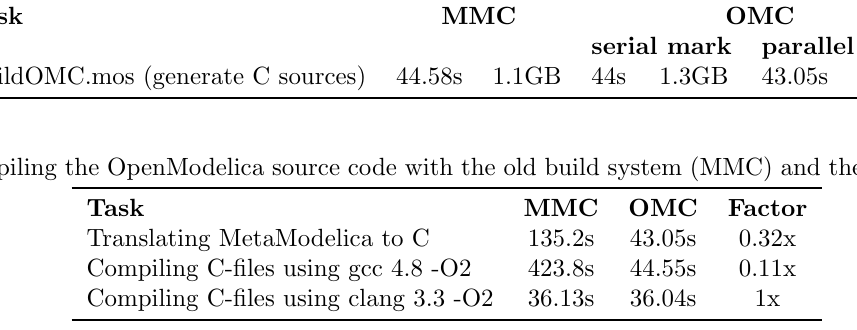
Table 6: Running BuildOMC.mos (the new build script for compiling OpenModelica). Task